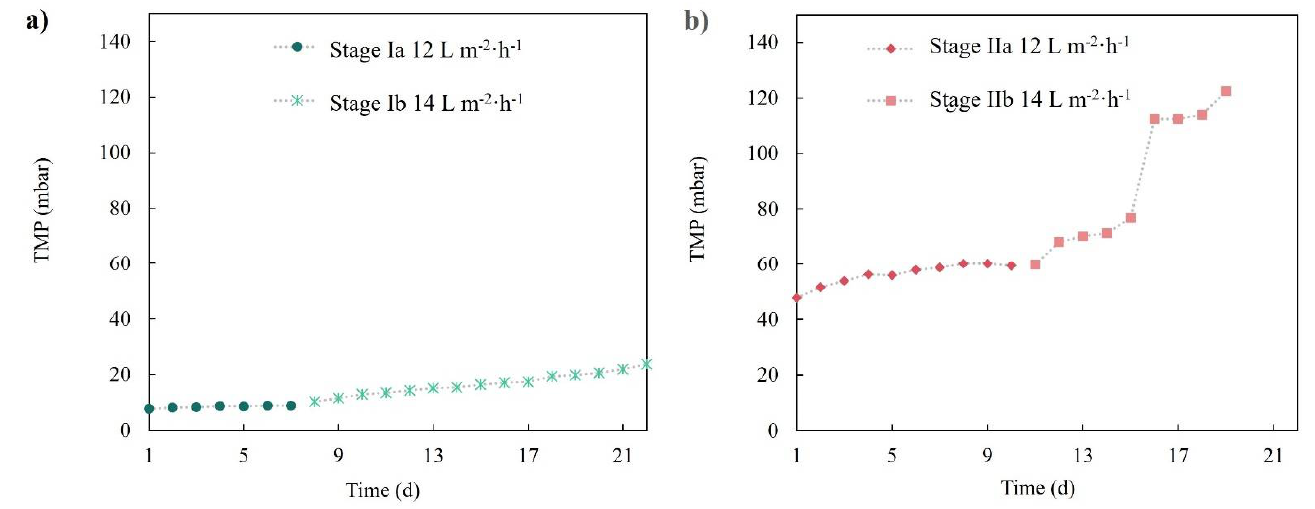
Figure 5. TMP temporal profile for ( a ) the c-MF membrane in stages Ia and Ib and ( b ) the r-UF membrane in stages IIa and IIb.